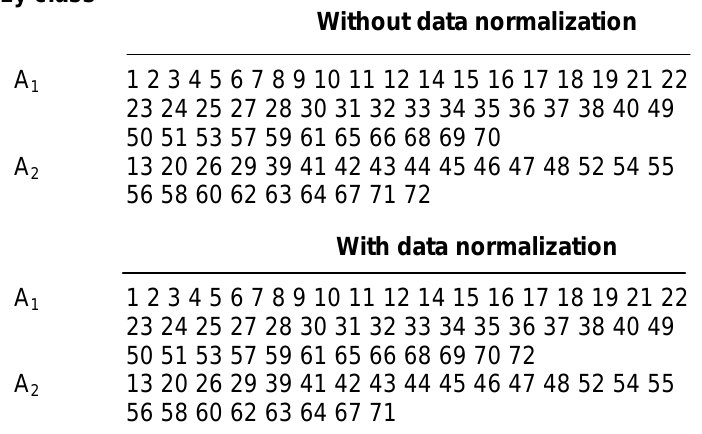
Cross-Classification of the Cardiac Patients and Characteristics Produced with Seven Non-Normalized and Normalized Descriptors Cardiac Fuzzy class